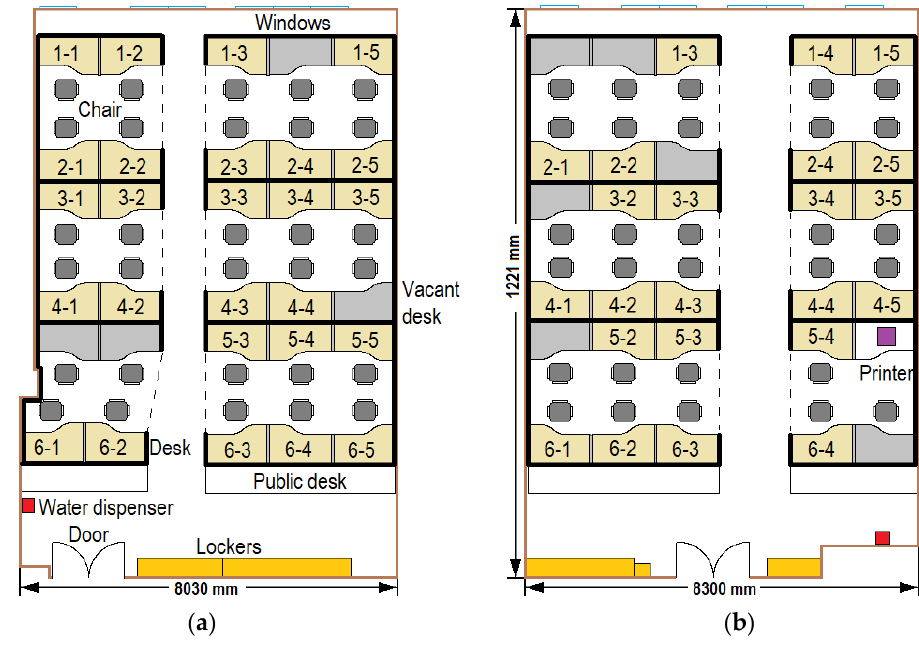
Figure 1. Room settings: ( a ) Room 1; ( b ) Room 2.